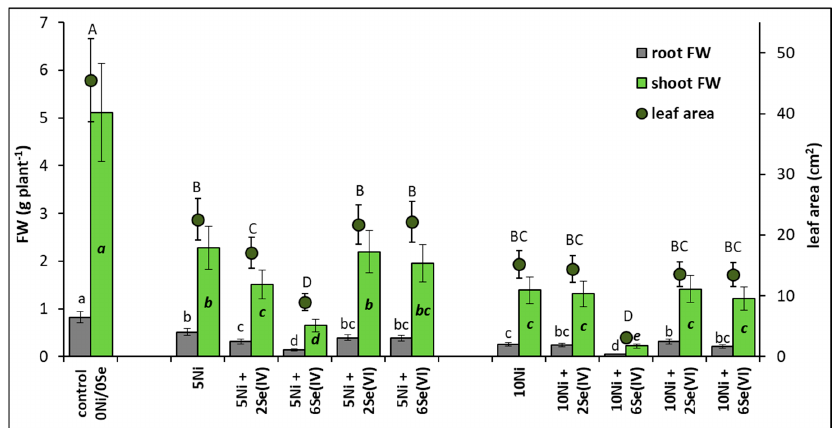
Figure 1. Effect of Se (selenite and selenate) supplementation on the growth parameters of Ni-exposed lettuce after 14 days of exposure. Data are means ± SD ( n = 24). Means for individual organs followed by the same letter are not significantly different ( p < 0.05, Tukey’s